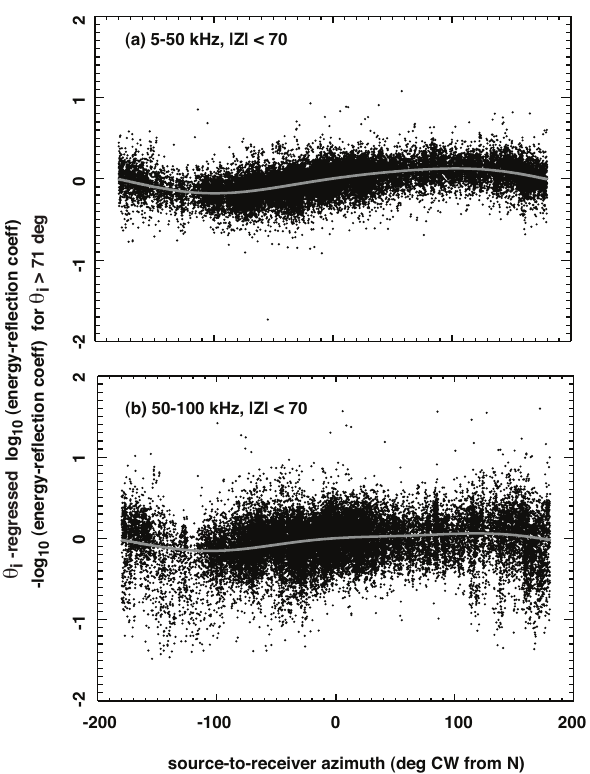
Fig. 8. Propagation-azimuth dependence of zenith- and range- regressed data for pure-daytime values of solar zenith angle. Si- nusoidal (fundamental + second harmonic) fit is shown as smooth